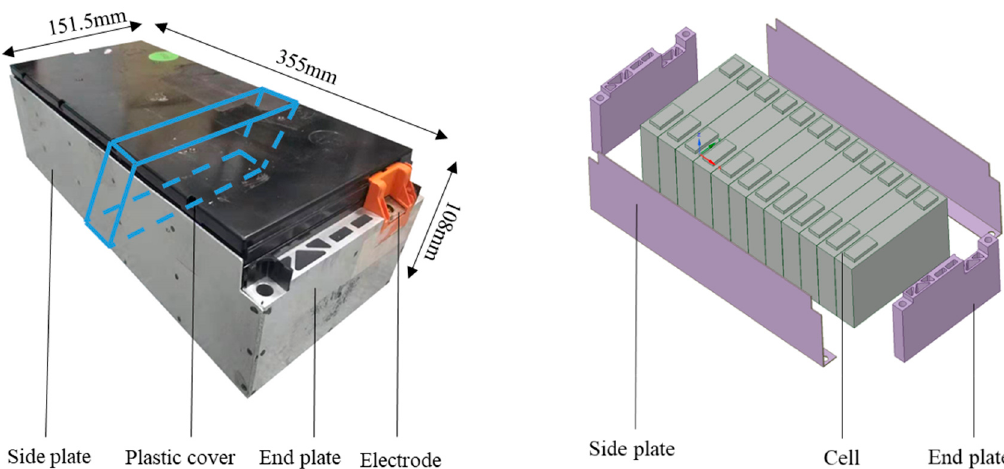
Figure 2. The composition of the battery module: ( a ) Actual appearance with dimensions; and ( b ) a simplified model.